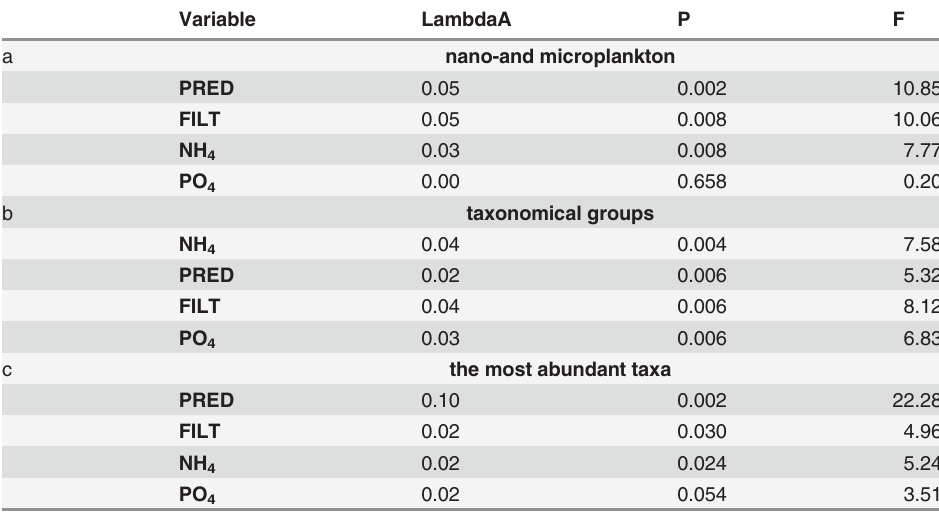
Table 2. Forward selection results of Monte Carlo test of relationships between phytoplankton (size fractions (a), taxonomical groups (b), the most abundant taxa (c)) and selected environmental factors directly dependent on restoration measures.